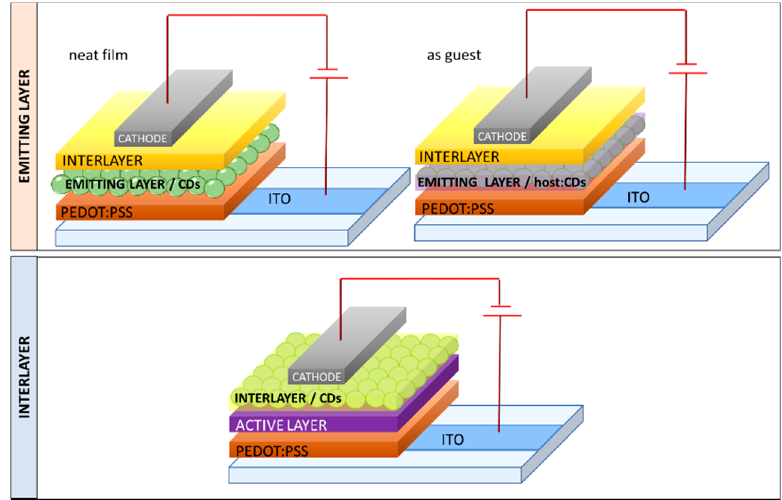
Figure 7. Scheme of the possible device architectures that incorporate CD as an emitter or as an interlayer. Table 1. Summary of organic light-emitting devices (OLEDs) incorporating a CD layer.